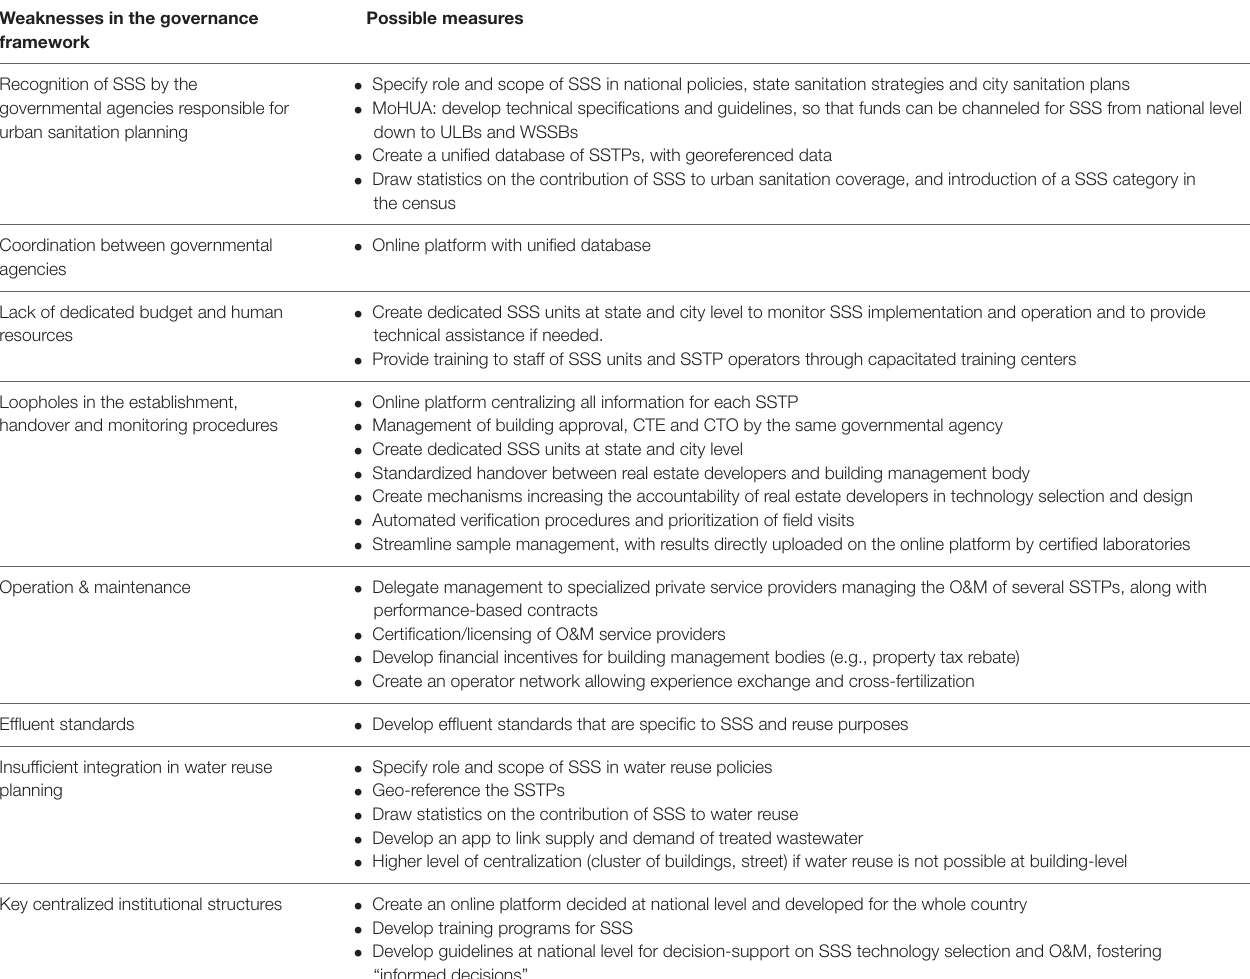
TABLE 2 | Weaknesses in the governance framework and measures recommended by the